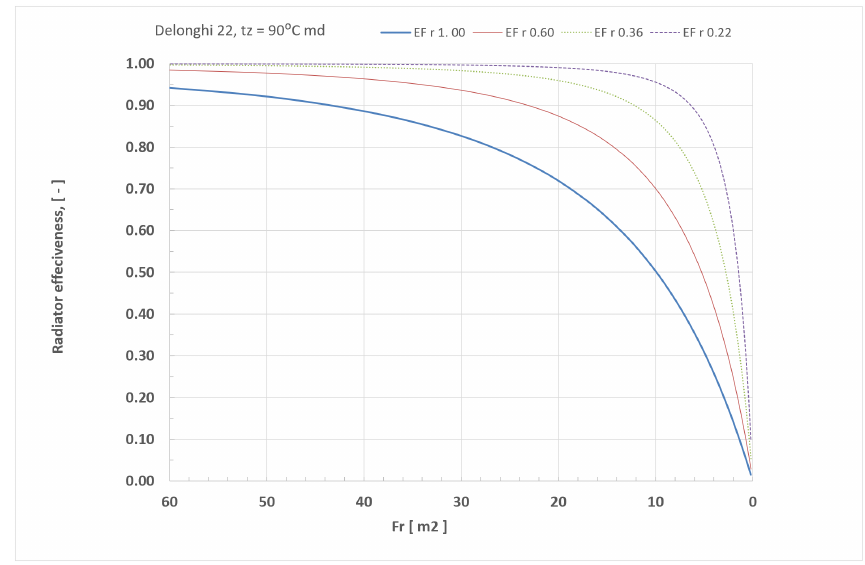
Figure 22. Delonghi -22, Radiator ef fectiveness as a function of radiator surface area. On Figures 23 and 24 for example, comparison between the result of the simulation calculations based on developed NEHTMiR md and measurements the temperature distri- bution of the water flowing through the radiator Delonghi type 22 and radiator surface temperature distribution along its height obtain from thermography measurements are provided (measurement 1 and 4)